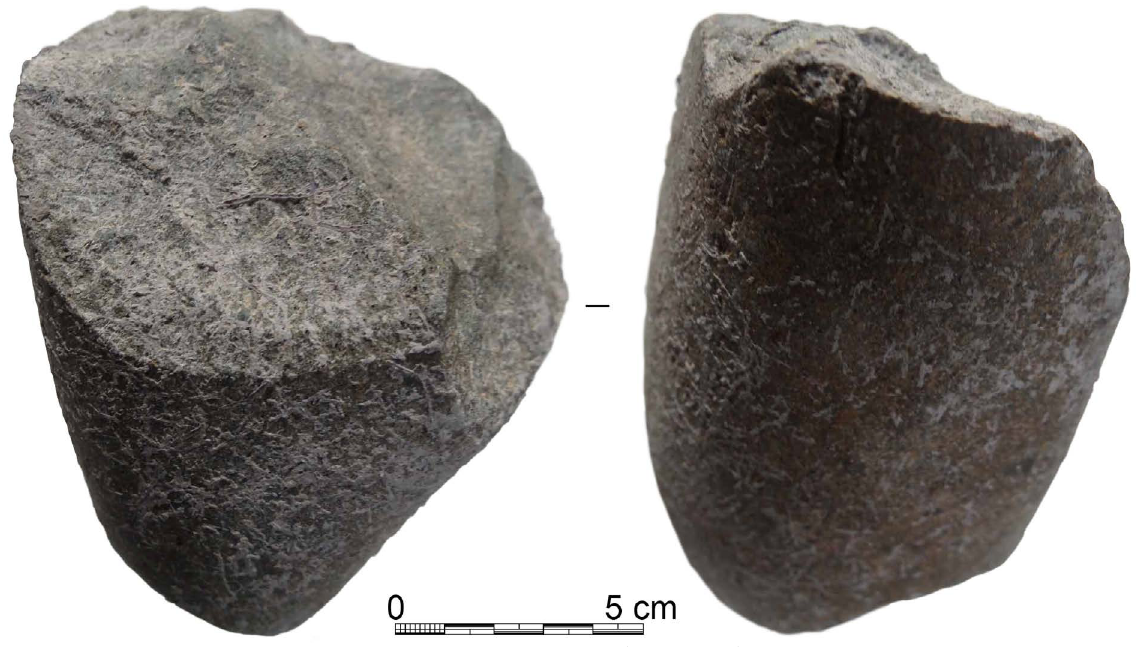
Figure 9. Chopper , site en grotte hoabinhien de Laang Spean (Cambodge). Figure 9. Chopper, Hoabinhian site of Laang Spean cave (Cambodia).